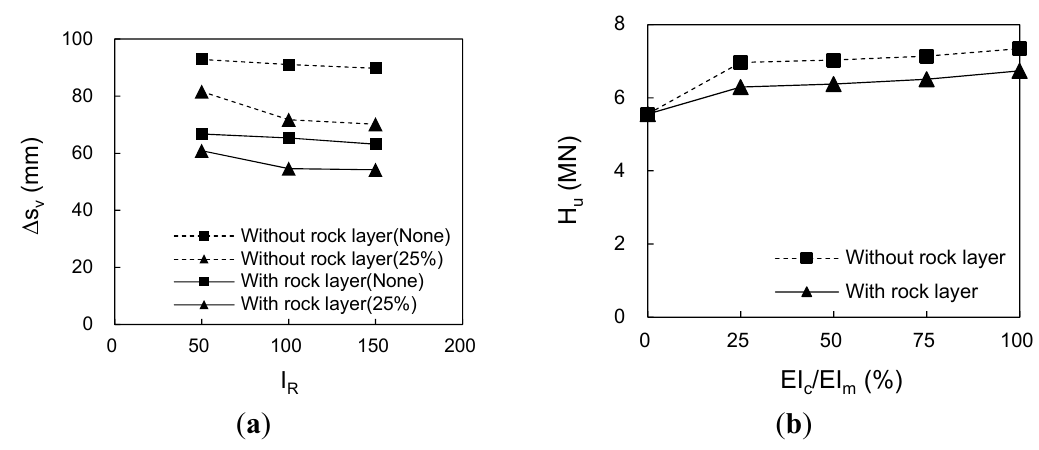
Figure 15. Differential settlement and lateral load capacity for different rock layer conditions: ( a ) differential settlement and ( b ) lateral load capacity of tower